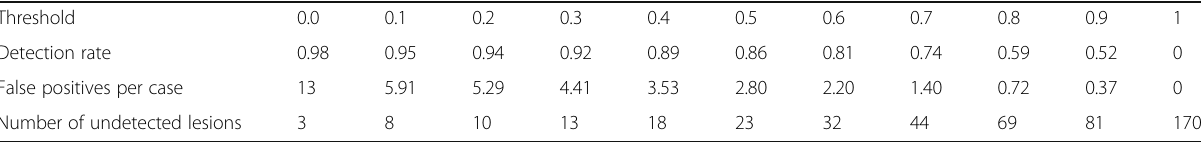
Table 1 The result of detection rate, false positives, and number of undetected lesions according to the different threshold values Threshold